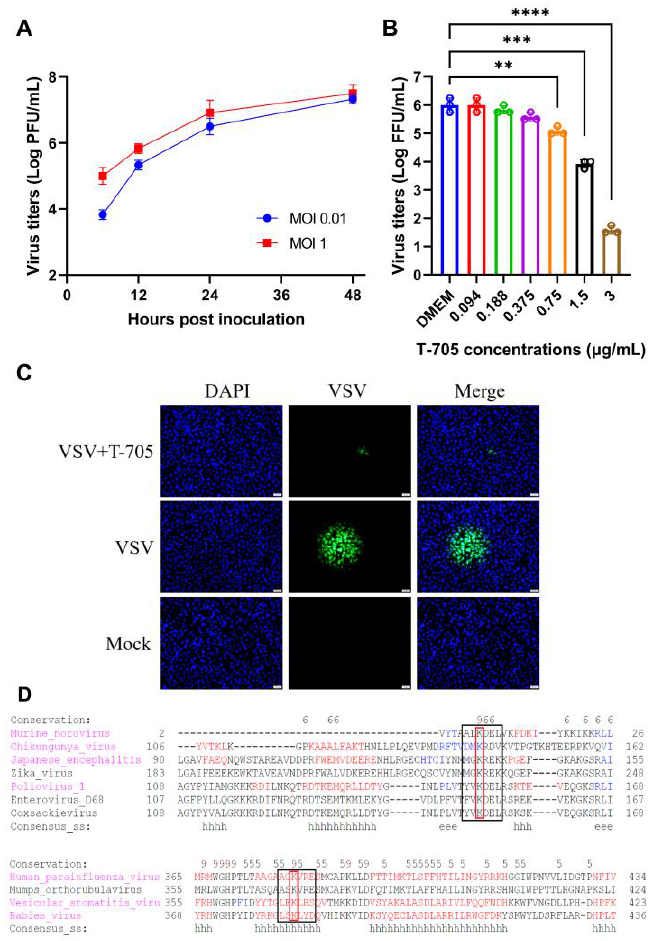
Figure 4. Viral inhibition by T-705 and the motif alignment at the entry site in the RdRp. ( A ) N2a cells were infected with VSV-GFP at MOI of 0.01 and 1. Virus titers in the supernatant were determined at 6, 12, 24, and 48 h post-infection (hpi). The obtained virus titers at different hpi were used to plot the virus growth curves. ( B ) VSV-GFP infected (MOI = 0.01) N2a cells were treated with gradient dilutions of T-705 at concentrations of 0.094 to 3 μg/mL. ( C ) VSV-GFP infected (MOI = 0.01) cells were incubated with 100 μL of T-705 (3 μg/mL) for 48 h. The fluorescent spot was visualized by a fluorescence microscope in T-705 treated group, VSV virus control group, and mock-infected group. Scale bar 20 μm. ( D ) Motif alignment at the entry site of T-705 in the RdRp from positive- and negative-stranded neurotropic RNA viruses. Statistical analysis of grouped comparisons was carried out by Student’s t-test (ns represents not significant, ** p < 0.01; *** p < 0.001; **** p < 0.0001). The bar graph represents means ± SD, n = 3.